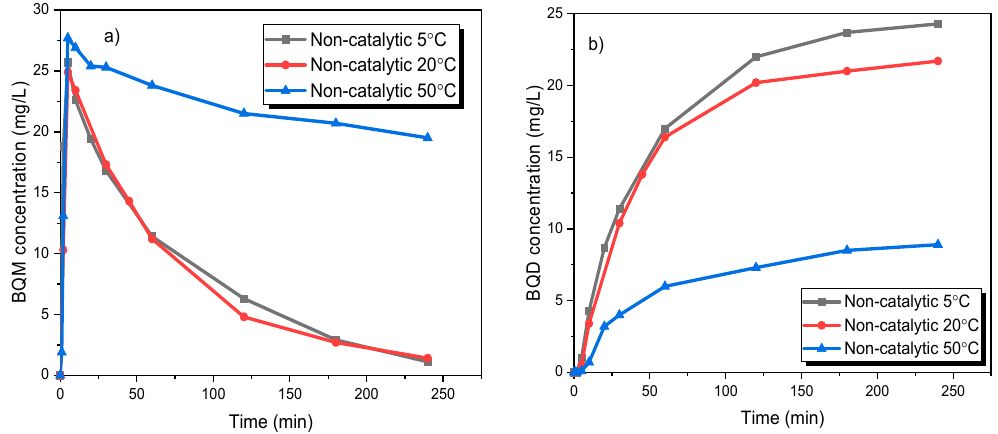
Figure 7. ( a ) BQM and ( b ) BQD concentration during the ozonation of CBZ. C CBZ = 35 mg/L, gas flow rate = 110 mL/min, T = 5 °C, 10 °C, 20 °C and 50 °C, stirring speed = 900 rpm, C O3, g = 21 mg/L.